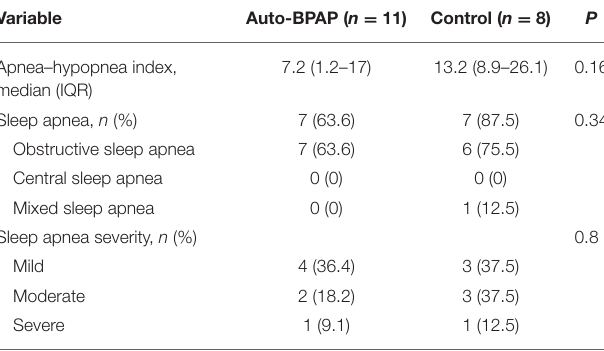
TABLE 2 | Adverse events and secondary clinical outcomes. TABLE 3 | Results of cardiorespiratory